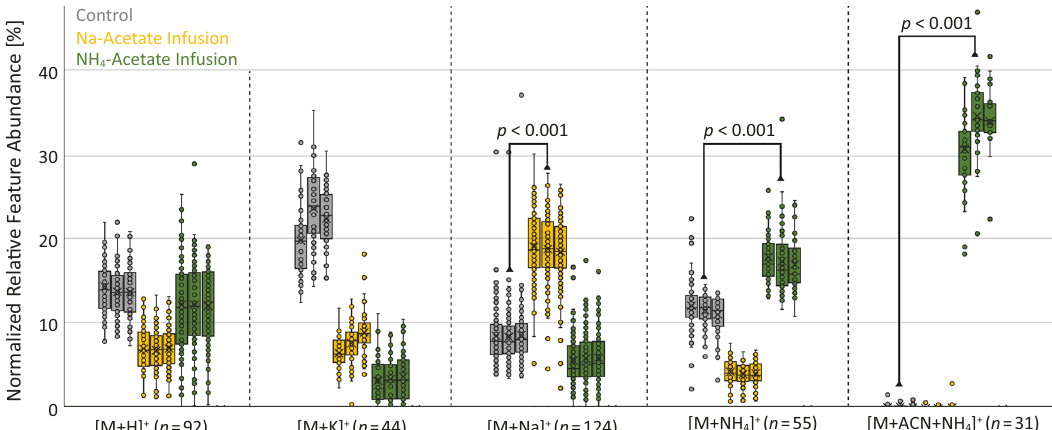
Fig. 3 Statistical impact of salt addition experiments on ion identity abundances. The relative intensities of selected ion identities are plotted for each post-column infusion in triplicate. The signi fi cant change for [M + Na] + and [M + NH 4 ] + ion identities in the corresponding post-column salt infusions compared to the control samples agree with the expected ionization behavior. The exclusive formation of an uncommon [M + ACN + NH 4 ] + in-source cluster in the ammonium acetate buffer infusion further veri fi es ion identity networking results. Boxplots visualize the median as a horizontal line, the mean as an x, the fi rst (Q1) and third quartile (Q3) as the lower and upper hinges, and the whiskers corresponding to the minimum value below Q1 and the maximum value above Q3 within the 1.5 × IQR (where IQR is the interquartile range). The p -values of a Welch two-samples t -test and the corresponding number of ion identities n are provided for each pair of compared triplicate injections with different post-column salt infusion conditions. Source data are provided as a Source Data fi (Supplementary Fig. 5, Supplementary Table 2). Annotation rates